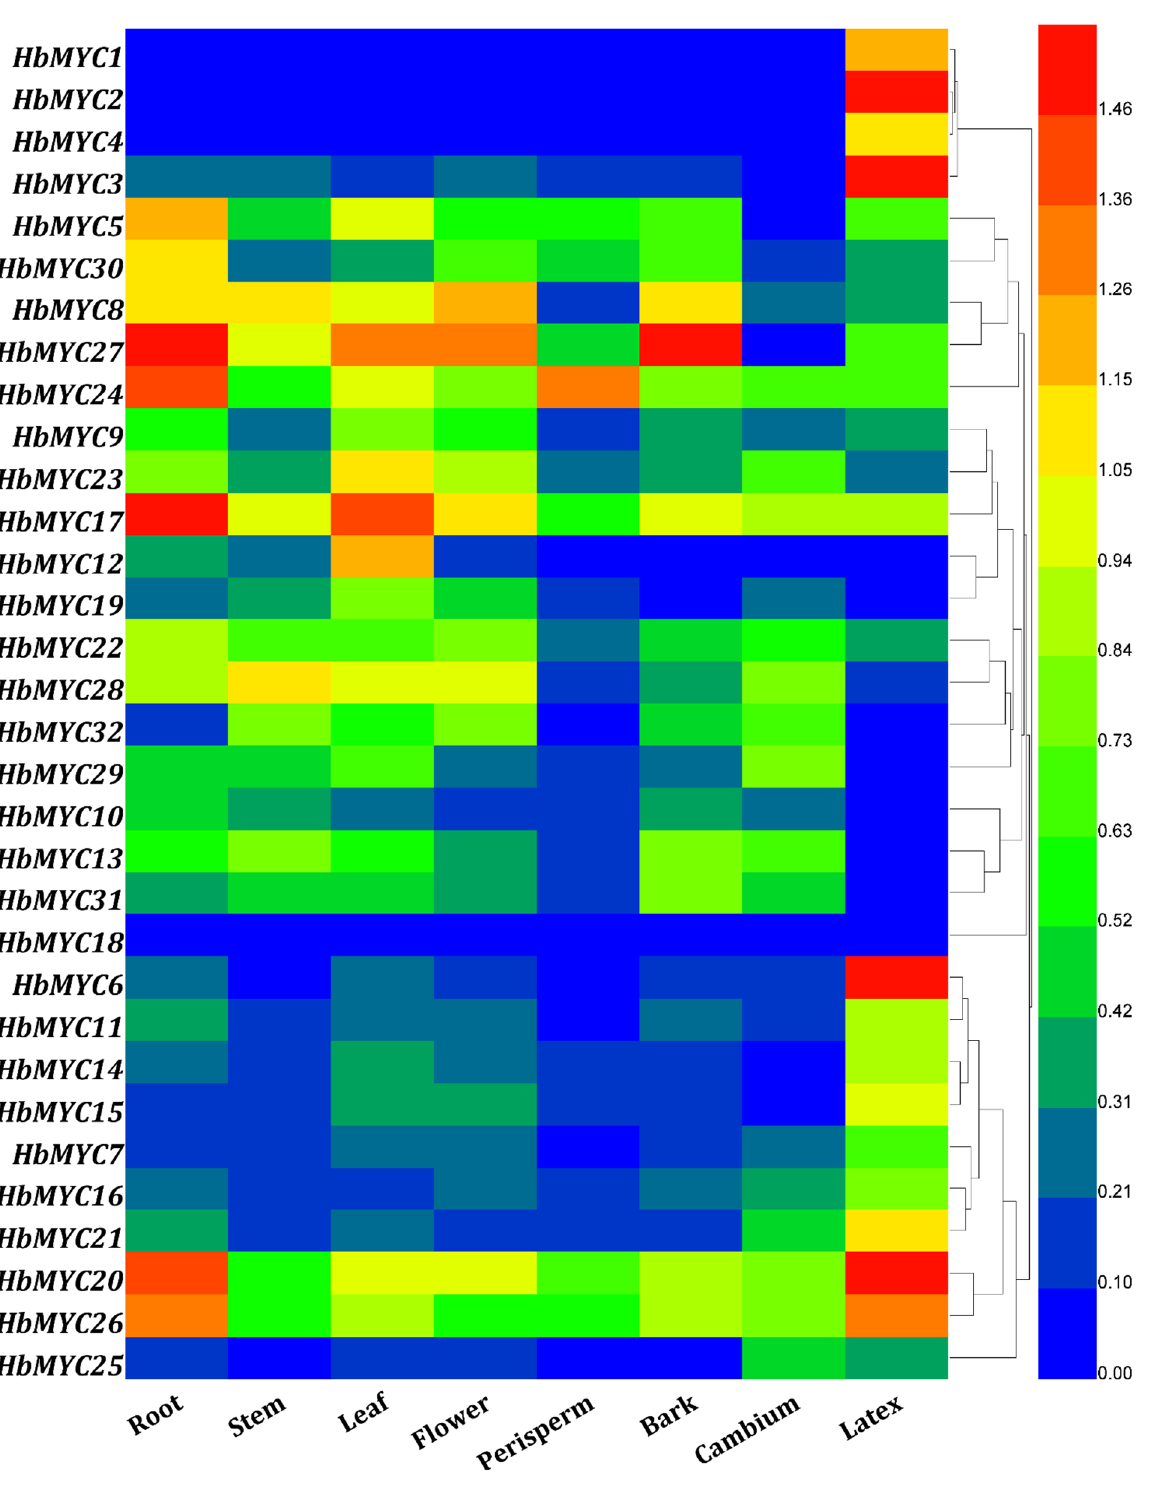
Figure 4. Tissue-specific expression of the HblMYCs . Eight typical tissues, i.e., feeder root (Root); stem at bronze stage (Stem); mature leaf (Leaf); female flower (Flower); perisperm of seed (Perisperm); trunk bark (Bark); cambium region of stem at stationary phase (Cambium); and latex of virgin tree (Latex) of rubber tree clone CATAS7-33-97 were collected without any treatments at the same time. Each tissue samples from a mixture of three trees. Values are means ± SD of three replicates. The heat maps were drawn by the software of HemI 1.0.